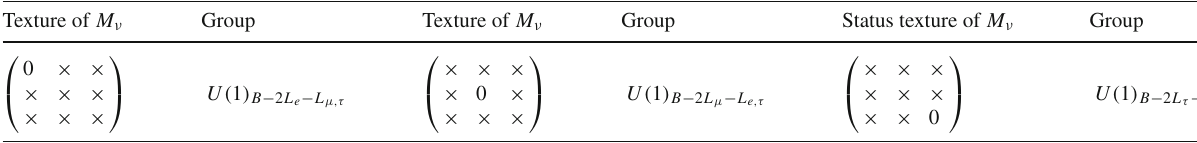
Table 3 Same as 2, but for one texture-zero Texture of M ν Group Texture of M ν Group Status texture of M